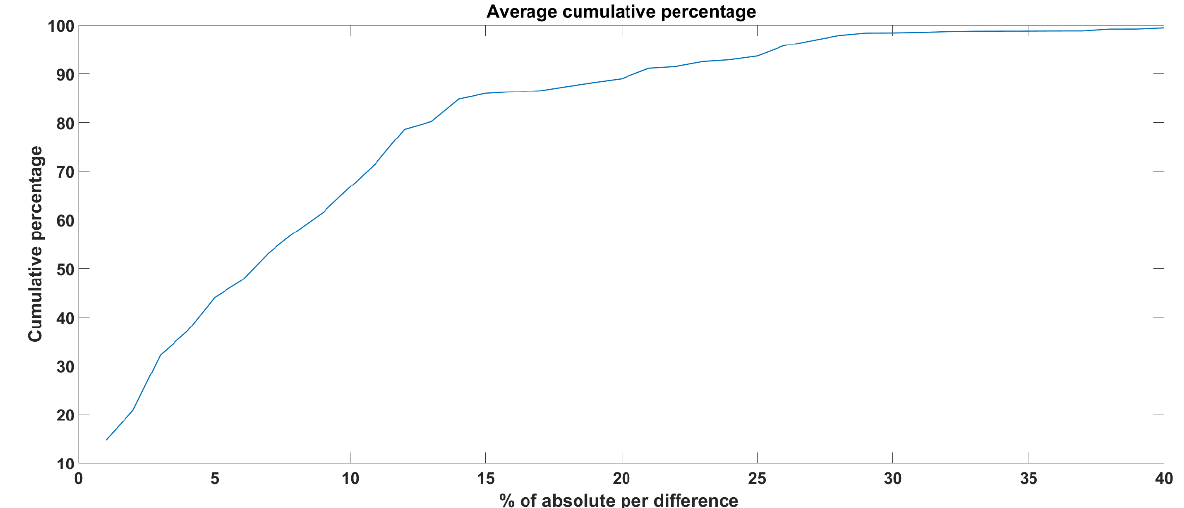
Figure 11. Average cumulative percentage of all 30 test subjects considering raw signals both extracted by the proposed